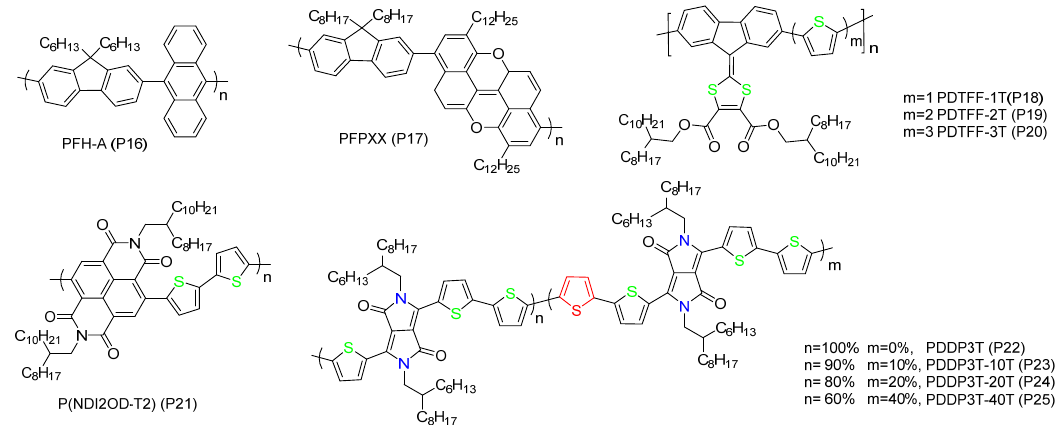
Figure 5. Chemical structure of copolymers containing large backbone units and some donor ‐ acceptor (D ‐ A) type conjugated polymers. (D-A) type conjugated